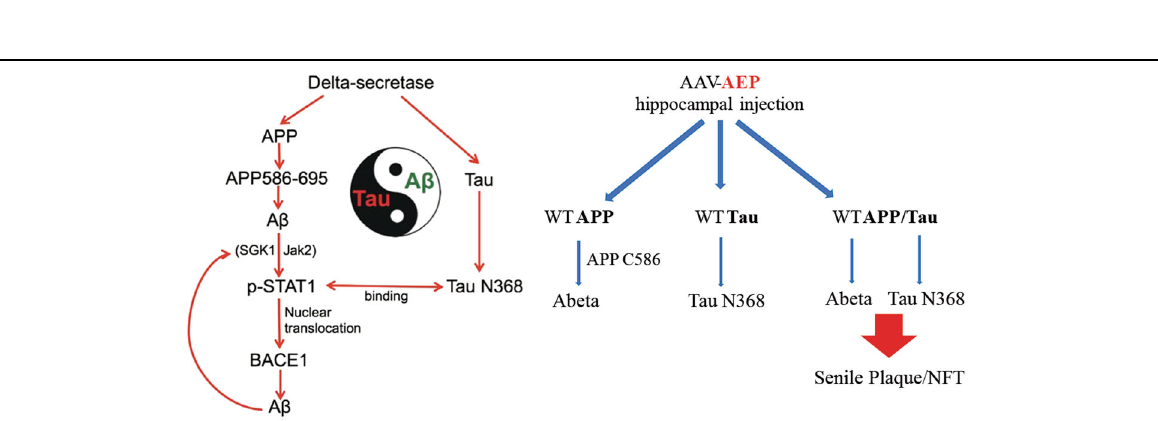
Fig. 2 Schematic model of δ -secretase-generated APP and Tau fragments on BACE1 expression. δ -Secretase cleaves APP, generating an APP (586 – 695) fragment, which is further cleaved by β -secretase and γ -secretase to produce A β . A β induces the phosphorylation of SGK1 and JAK2,